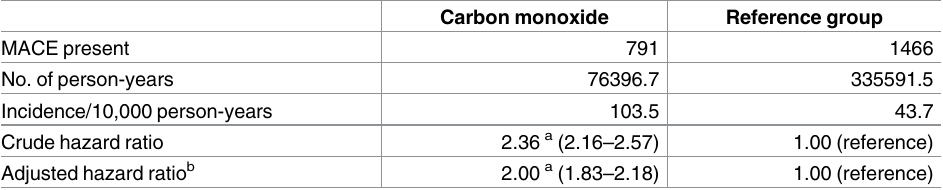
Table 2. Incidence and adjusted hazard ratios for MACE during the 9-year follow-up period.